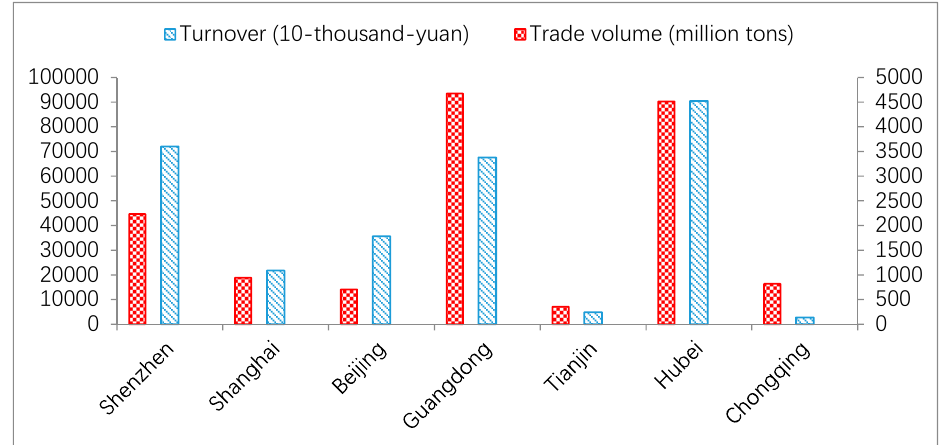
Figure 4. Seven-pilot carbon trade market’s cumulative trade volume and turnover from May 2014 to January 2018.